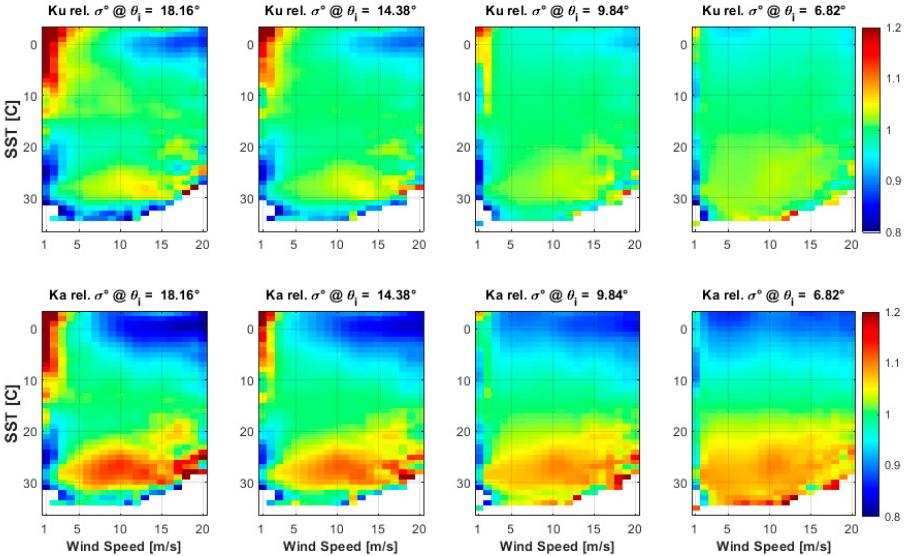
Figure 23. Relative SST impacts on KuPR ( top ) and KaPR ( bottom ) mean σ 0